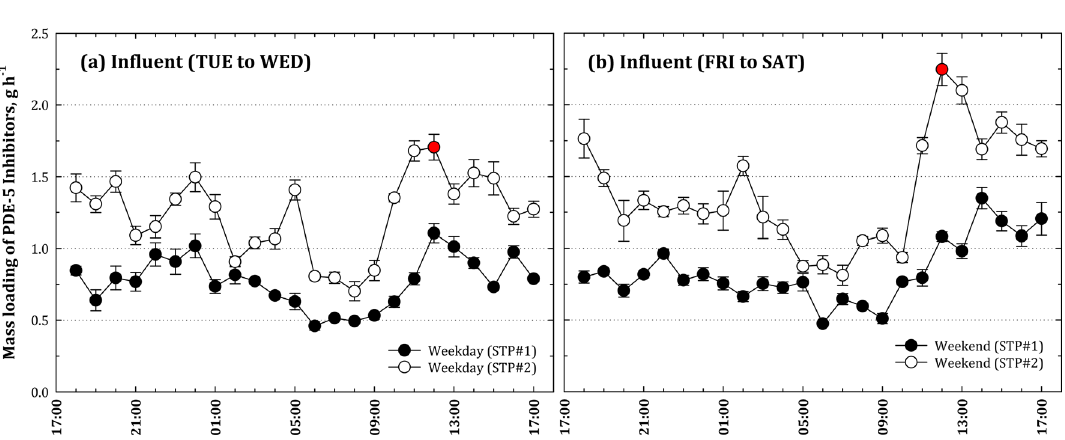
Figure 2. 24-h profiles of PDE-5i mass loading on STP#1 and STP#2 on ( a ) weekday and ( b ) weekend. Red circles indicating peak of mass loading observed at STP#2 on weekday and